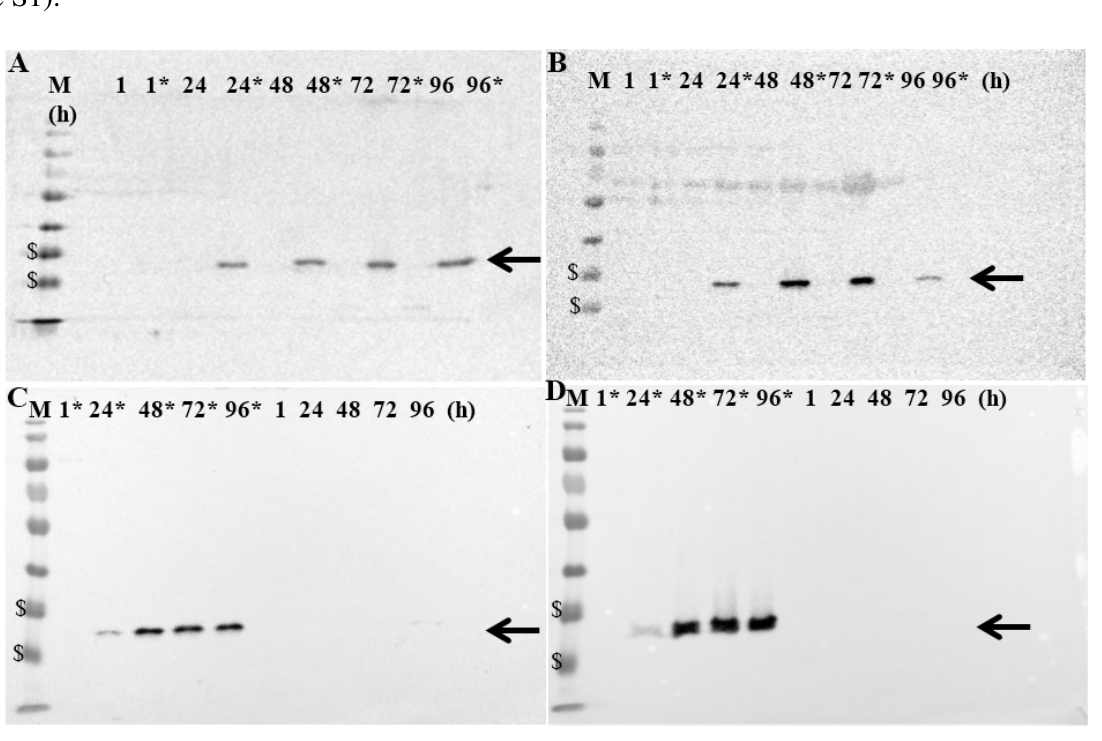
Figure 4. Expression of GLAF-2 protein in different canine cancer cells: ( A ) MTH52c; (B ) ZMTH3; ( C ) CT1258 and ( D ) STSA-1. Western blot analysis of GLV-5b451-infected (MOI of 1.0; lines marked by *) or uninfected canine cancer cells. Protein fractions from cell lysates were isolated at 1, 24, 48, 72 and 96 h post virus infection and separated by SDS-PAGE. Western blot analysis was performed as described in material and methods. The position of GLAF-2 protein is marked by black arrow. M: PageRuler Prestained Protein Ladder # 26616 (Thermo Scientific, Bonn, Germany). The positions of the 35 and 25 kDa proteins are marked by $ symbol.